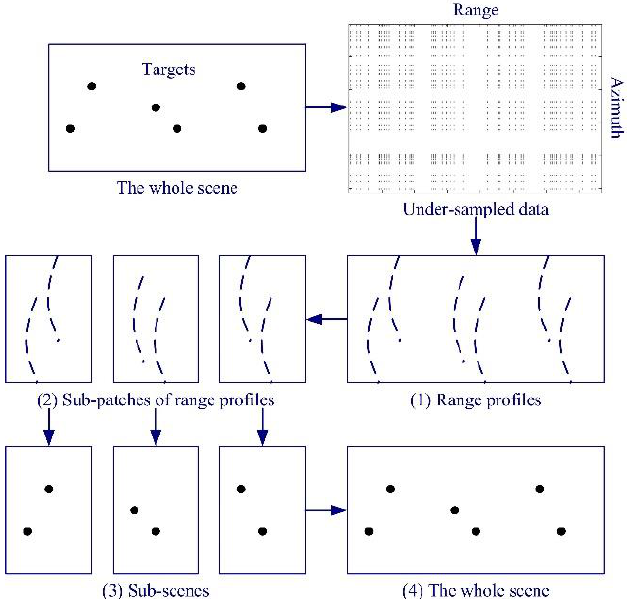
Figure 7. Processing steps of the segmented reconstruction method for CS-based synthetic aperture radar (SAR) imaging (taken from [71]).